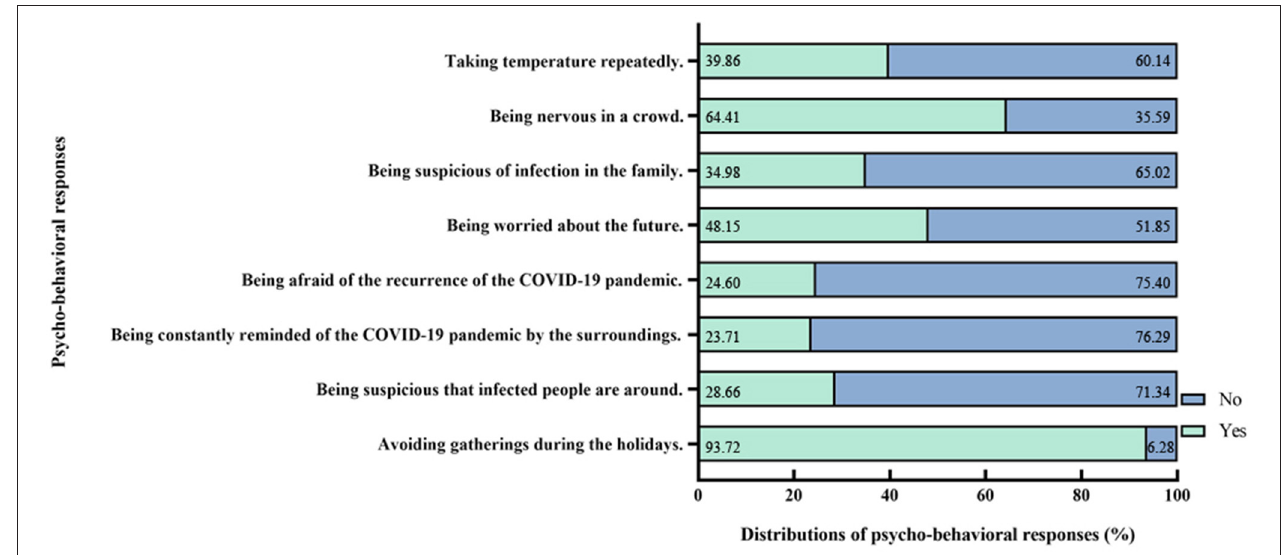
FIGURE 1 | Psycho-behavioral responses and distributions of